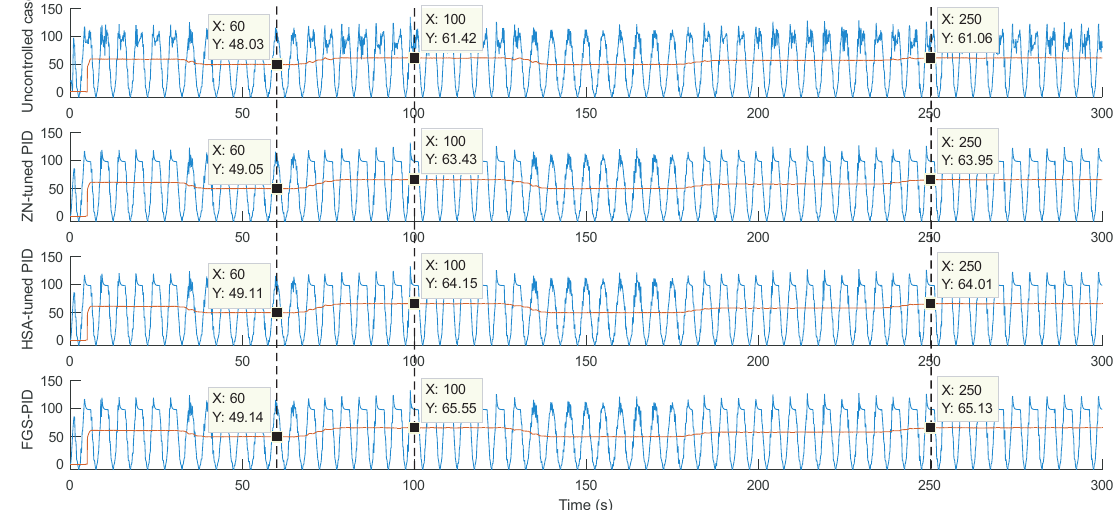
Figure 23. Turbine torque with different control methodologies in irregular waves.